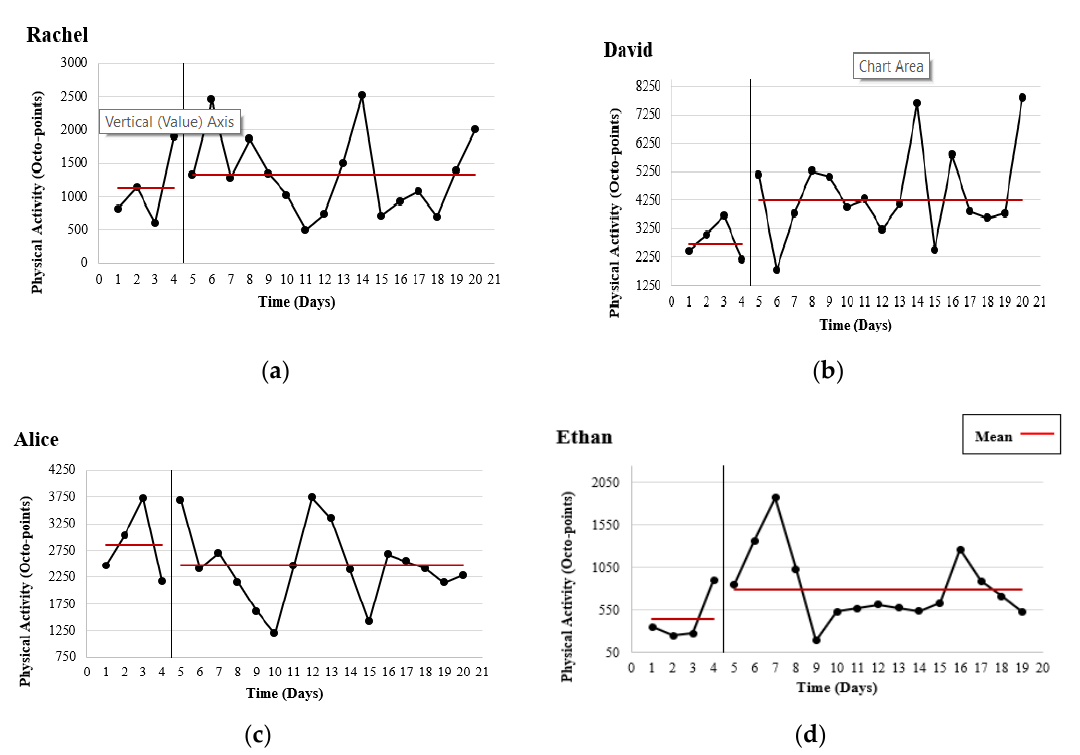
Figure 2. Graphical depiction of physical activity (PA) at baseline (Days 1–4) and during the Octopus watch intervention (Days 5–20) for each participant. Table 4. N-of-1 analyses comparing baseline and intervention PA.